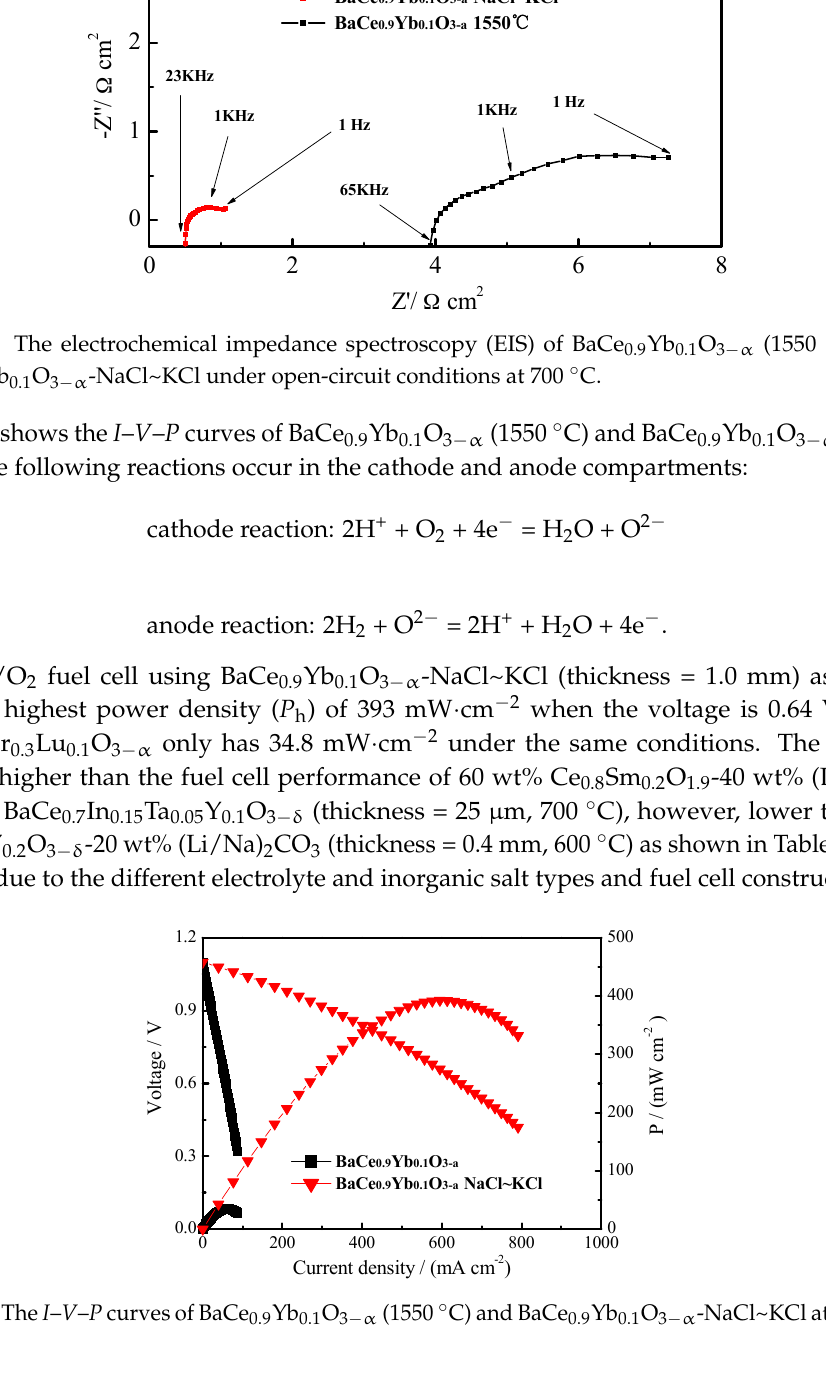
◦ C) and BaCe ◦ 0.9 Yb 0.1 O 3 − α -NaCl~KCl at 700